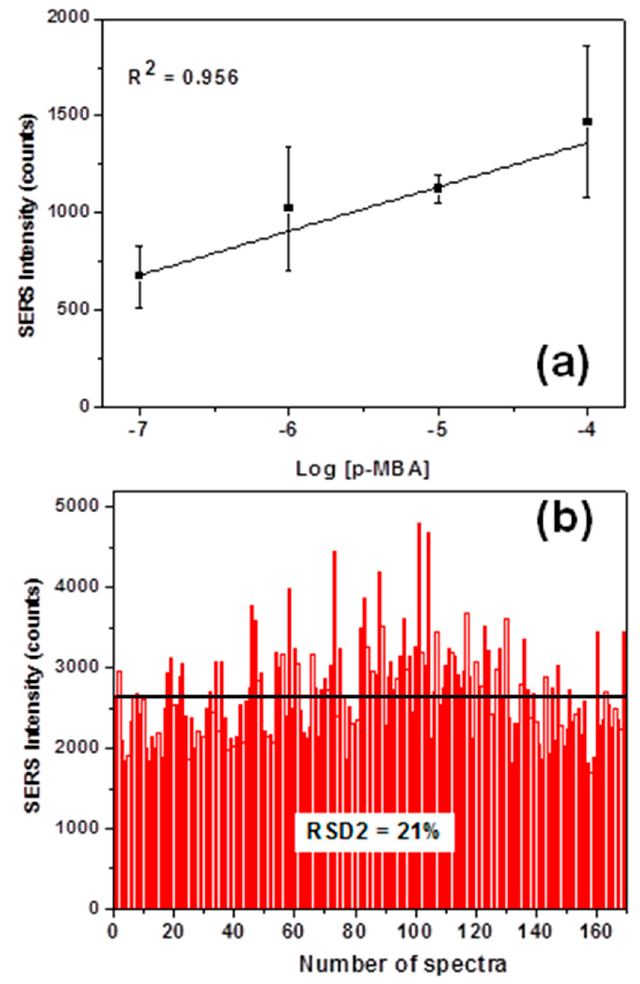
Figure 4. ( a ) Dependence of the average SERS intensity at 1074 cm − 1 , with the logarithm of the p-MBA concentrations. ( b ) SERS intensities distribution at 1074 cm − 1 for the Raman mapping on AuNHAS of the 10 − 6 mol L − 1 p-MBA solution. Laser wavelength: 633 nm; laser power: 2.5 mW.